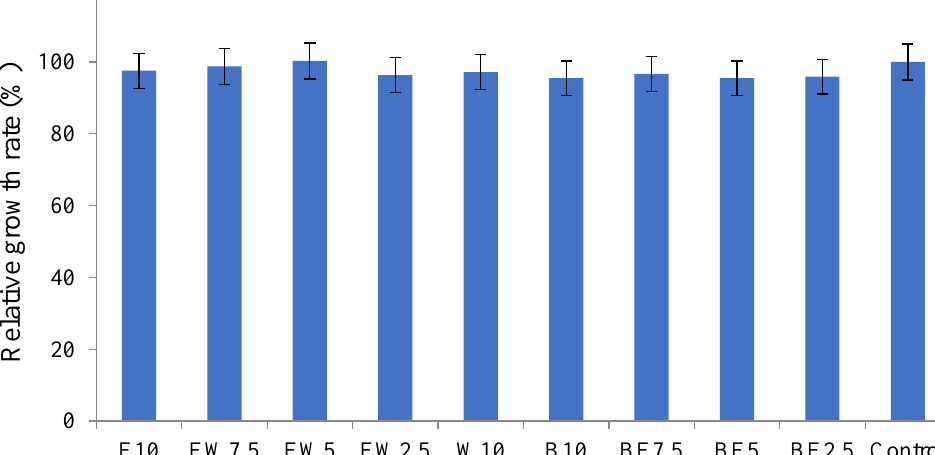
Figure 1. Relative growth rate of HaCaT cells in the presence of A. scorodoprasum flower extracts at concentration 400 μg/mL.